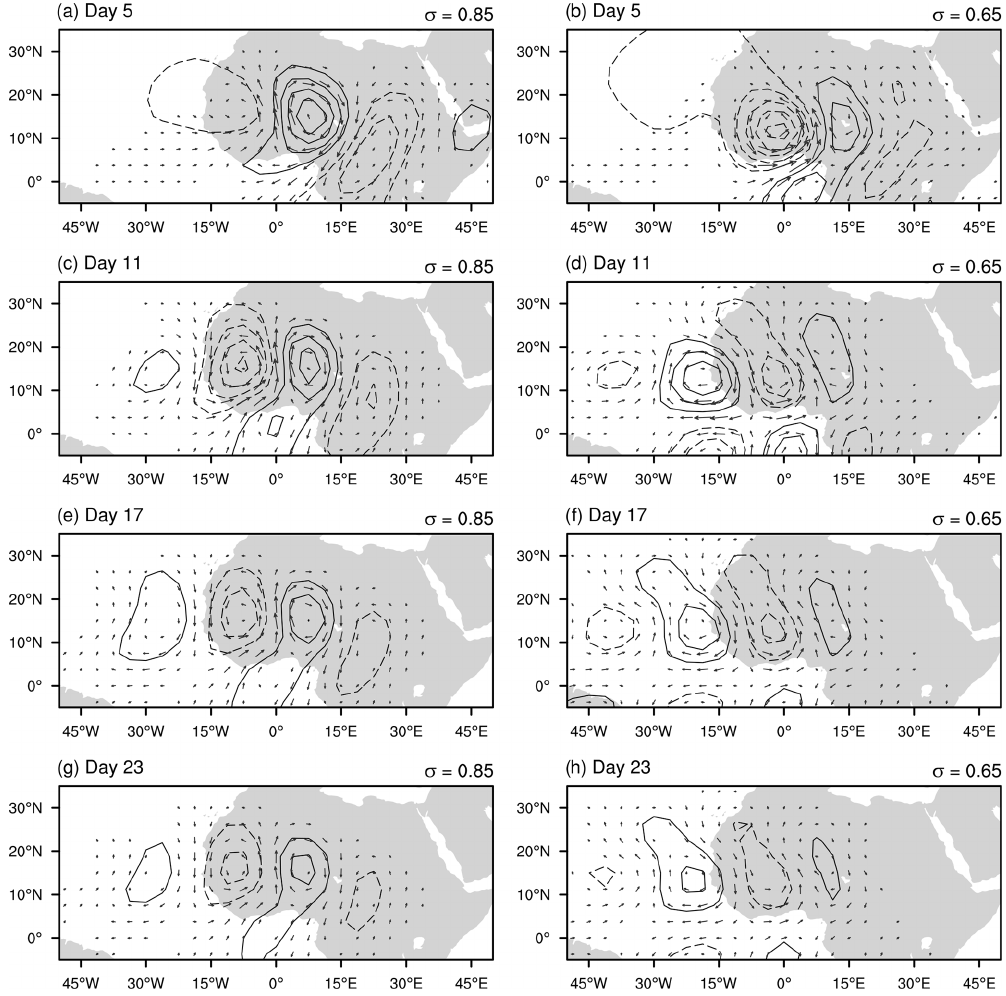
Figure 8. Streamfunction (interval 1 × 10 5 m 2 s − 1 with negative values dashed) and horizontal wind vectors at σ = 0 . 85 (a, c, e, g) and 0.65 (b, d, f, h) showing the wave response within the intermediate-lived basic state for days 5, 11, 17, and 23 from top to